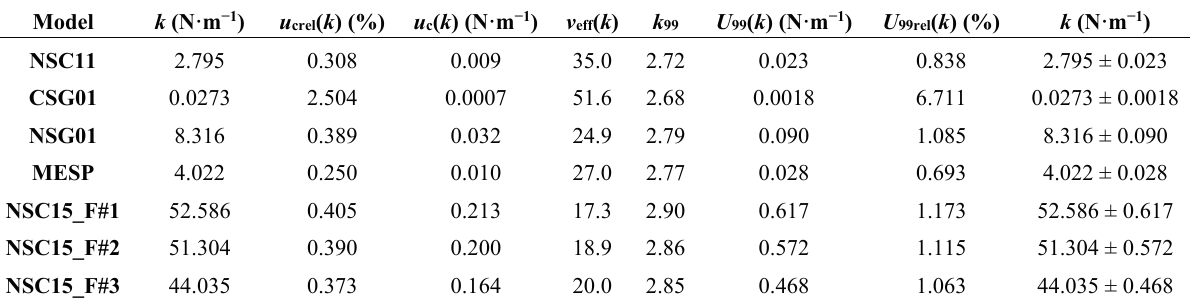
Table 5. Calibration resutls with expanded